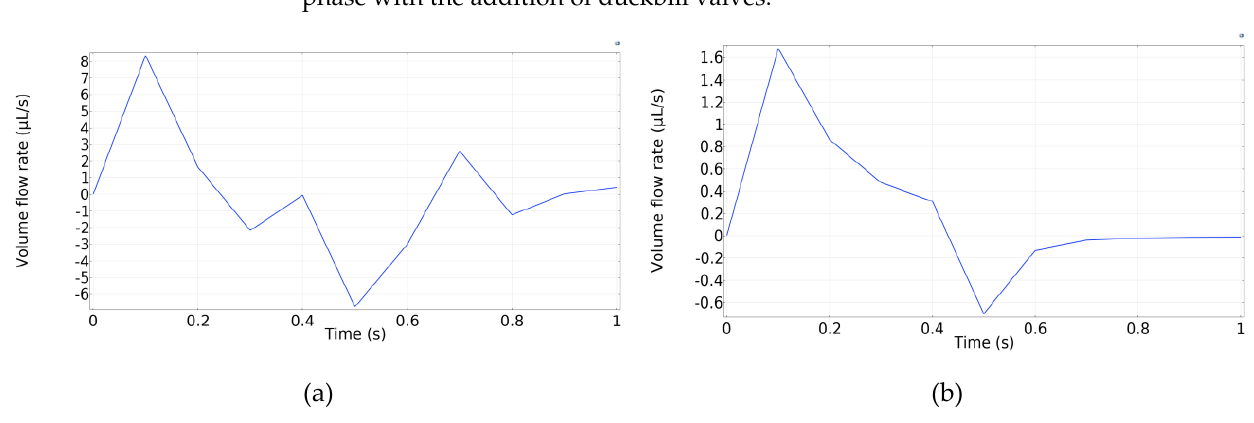
Figure 12. Simulation results for micropump with duckbill valves. ( a ) Velocity field at t = 0.1 s. ( b ) Volume flow rate vs. time. Figure 13 exhibits the volume flow rate during both contraction and retraction phases for (a) without valves and (b) with the duckbill valves. The figure shows that with the addi- tion of duckbill valves, the net backward flow reduced significantly during the retraction phase with the addition of duckbill valves.